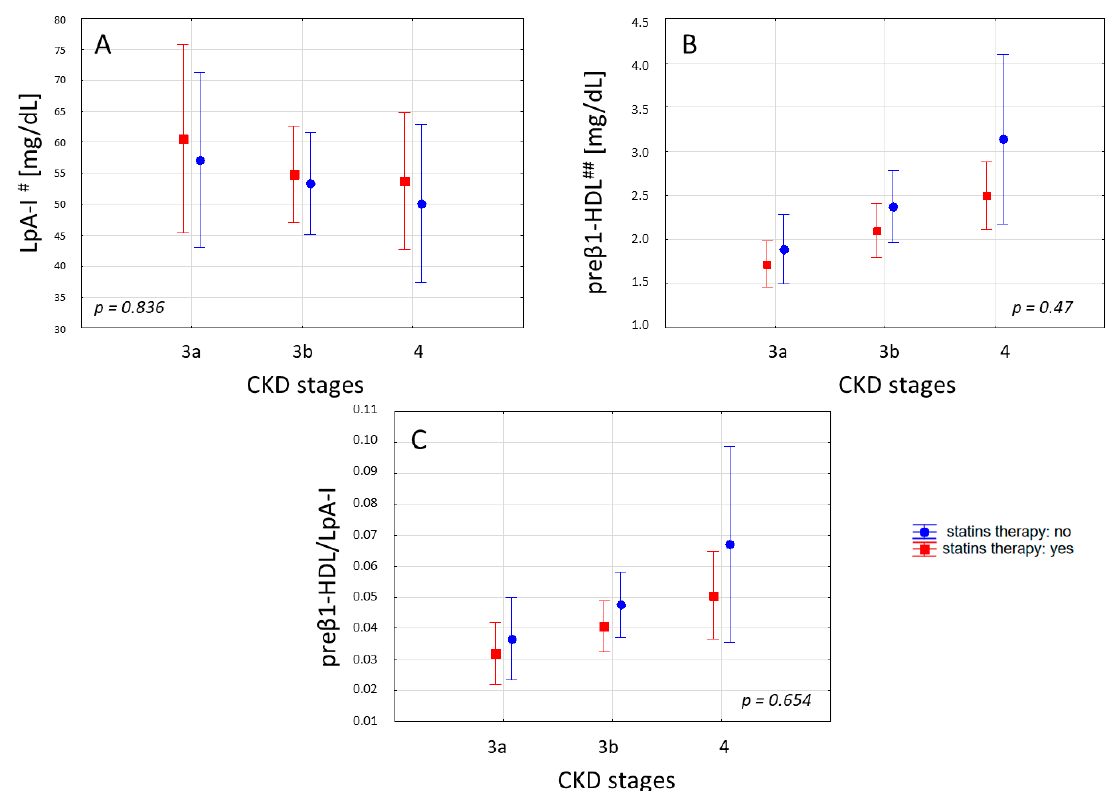
Figure 2. LpA-I ( A ), the pre β 1-HDL ( B ) concentrations, and the pre β 1-HDL/ LpA-I ( C ) values in the patients at various stages of CKD with and without statins therapy. Values are presented as mean ± 1.96 SE, and were assessed using the ANOVA test. # ApoA-I content of LPAI; ## ApoA-I content of pre β 1-HDL.